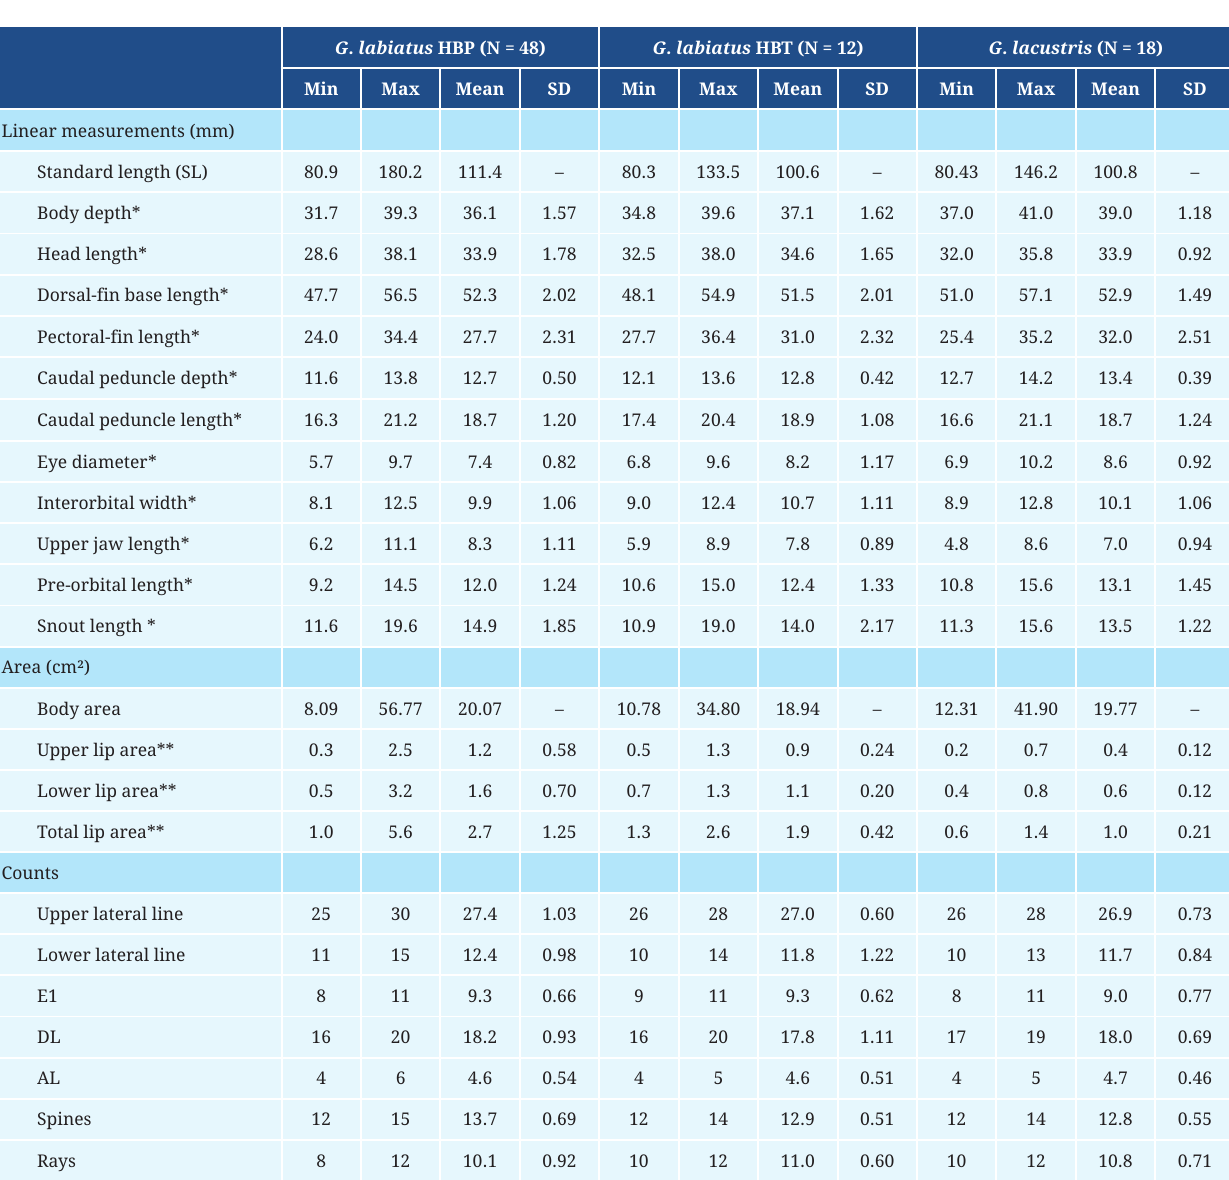
TABLE 4 | Morphological measurements for the analyzed Gymnogeophagus specimens. Min = minimum observed value; Max = maximum observed value; SD = standard deviation; *Values relative to standard length; **Values relative to body area; E1 = Scales in a longitudinal series; DL = Scales between the origin of the dorsal fin and the upper part of the lateral line; AL = Scales between the origin of the anal fin and the top of the lateral